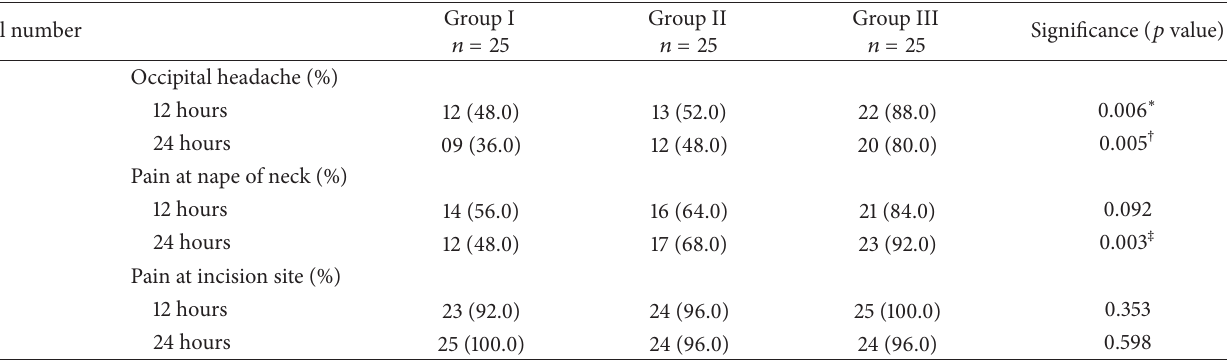
Table 2: Outcome in terms of occurrence of postoperative pain.